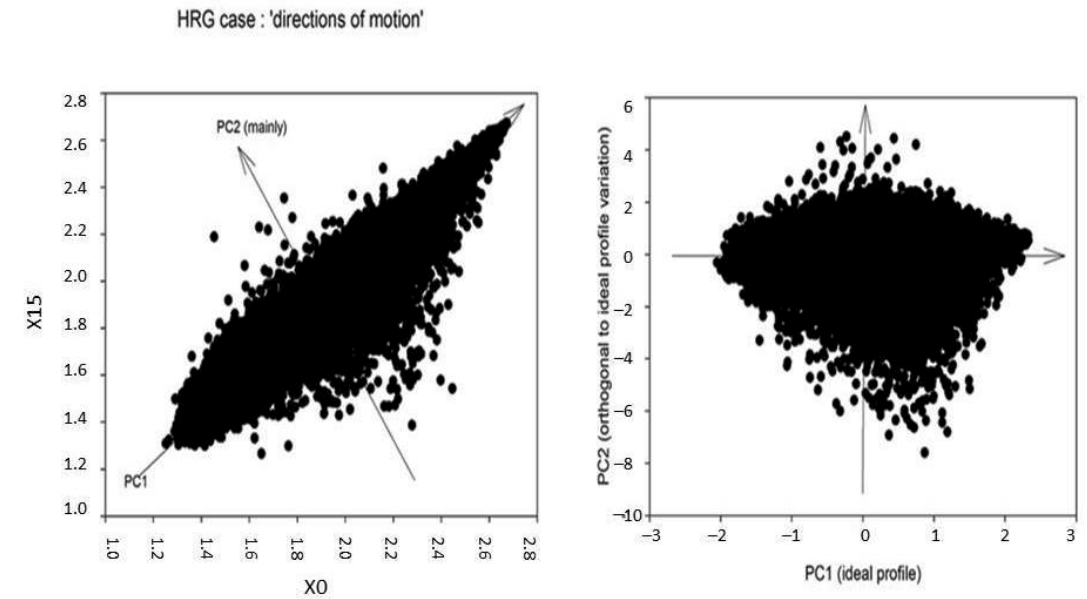
Figure 3. Left panel, the genome expression profile at X0 (equilibrium position) and X15 (transition): a direction of motion orthogonal to the main component (PC2) drastically increases in size, invading the core of the system. This invasion provokes the increase in variability of genes that in the equilibrium state were practically coincident with the line of identity (cell ‐ type attractor). Right panel, the same situation in the principal component space expressed in z ‐ scores.